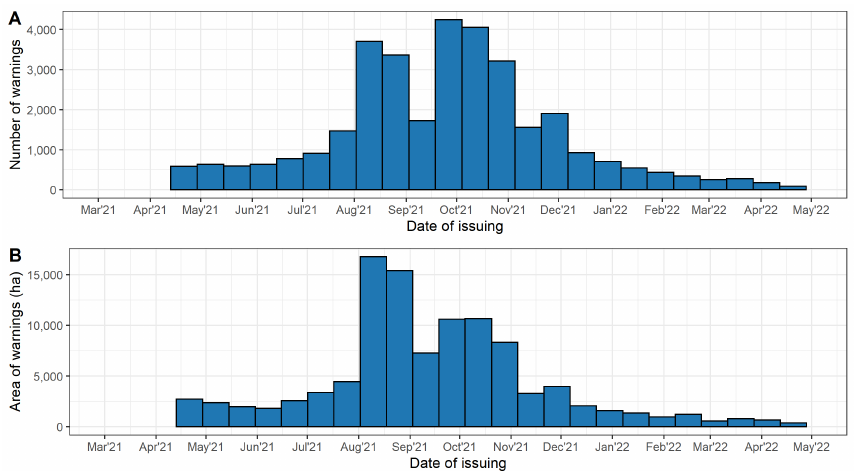
Figure 14. Timeline of DETER-R warnings not seen by the optical DETER in the same period sent to the Brazilian Institute of the Environment and Renewable Natural Resources (IBAMA) for field investigation ( A ) Number of warnings ( B ) Area of